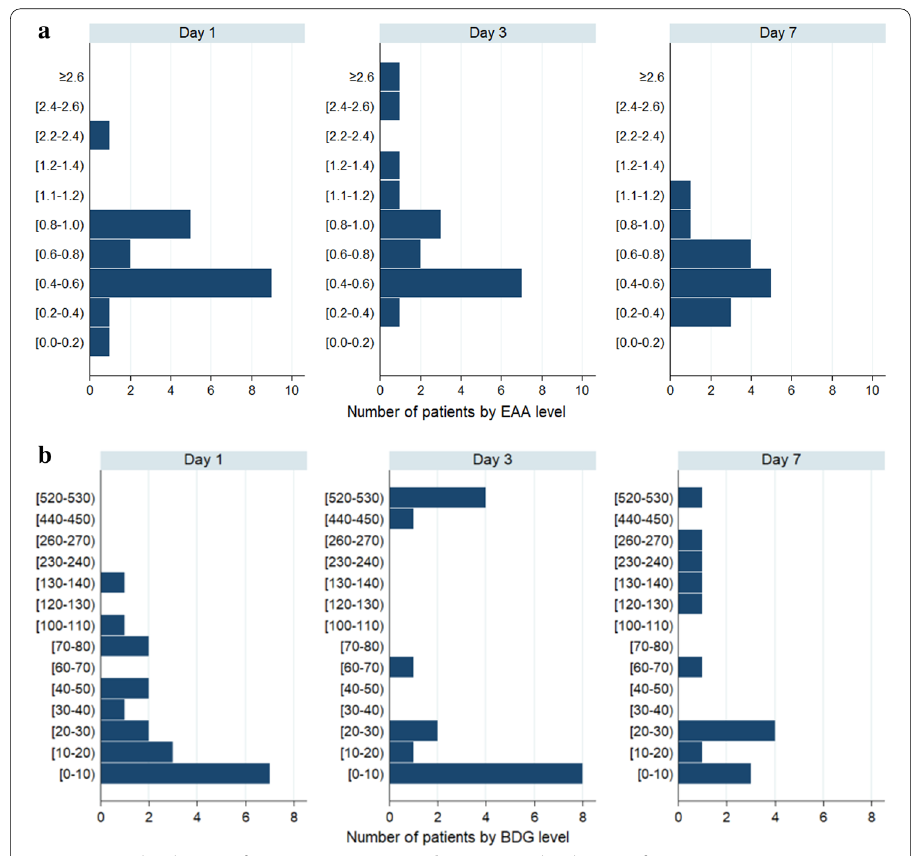
Fig. 2 a EAA distribution of COVID‑19 pneumonia. b Serum BG distribution of COVID‑19